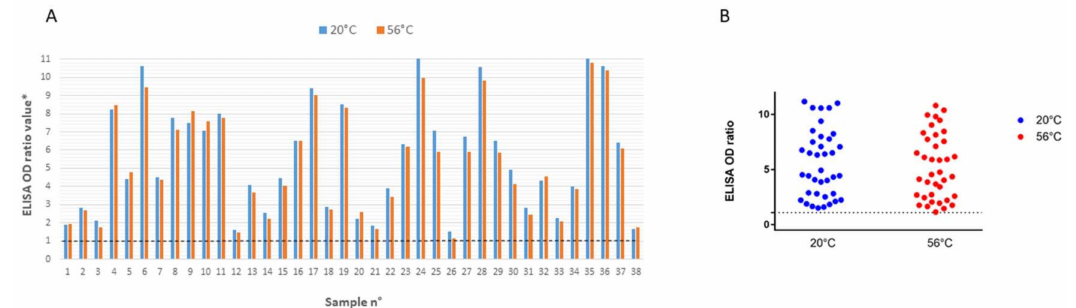
Figure 1. Impact of heat treatment at 56 ◦ C-30 min on the SARS-CoV-2 ELISA EuroImmun IgG assay compared with the same sera maintained at ambient temperature (20 ◦ C). Panel ( A ), histogram representation. ( B ): point cloud representation. Positivity threshold is represented by the discontinuous